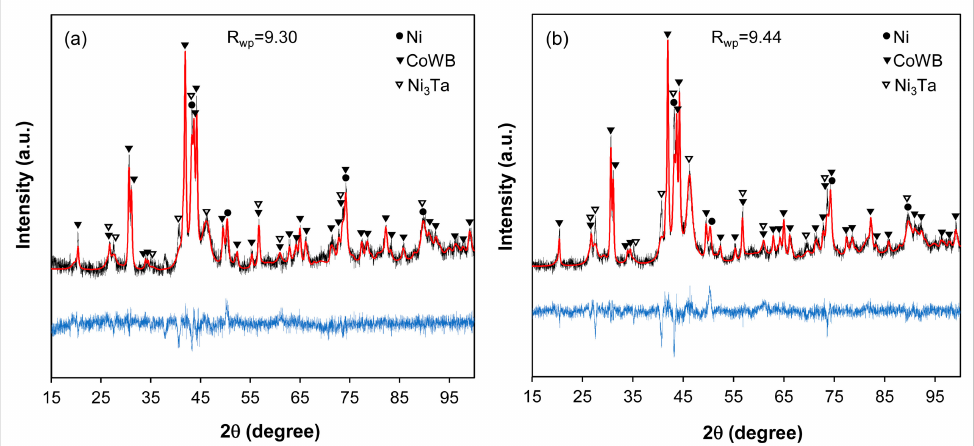
Figure 3. The Rietveld refinement of the XRD data of the composites produced by annealing the amorphous alloy at 1025 K for ( a ) 100 min, ( b ) 150 min. Observed data is indicated by black color. Calculated and difference data are represented by red and blue colors, respectively.